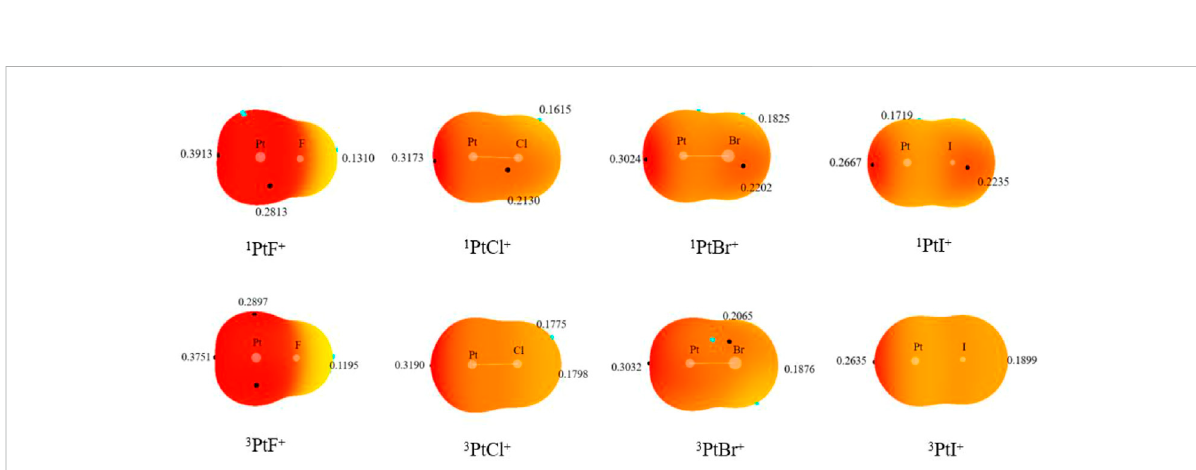
FIGURE 6 Molecular electrostatic potential (MEP) maps on the 0.001 a. u. isodensity surface of the monomers.